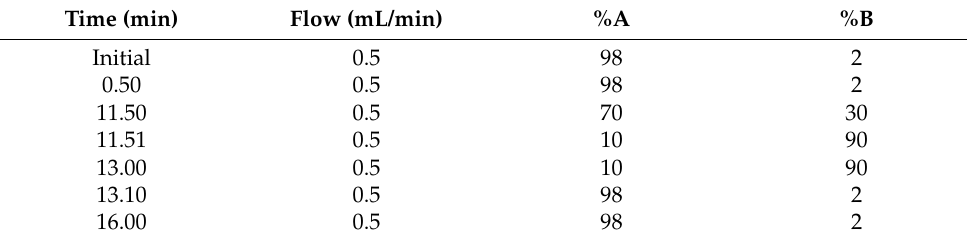
Table 2. Chromatographic gradient.